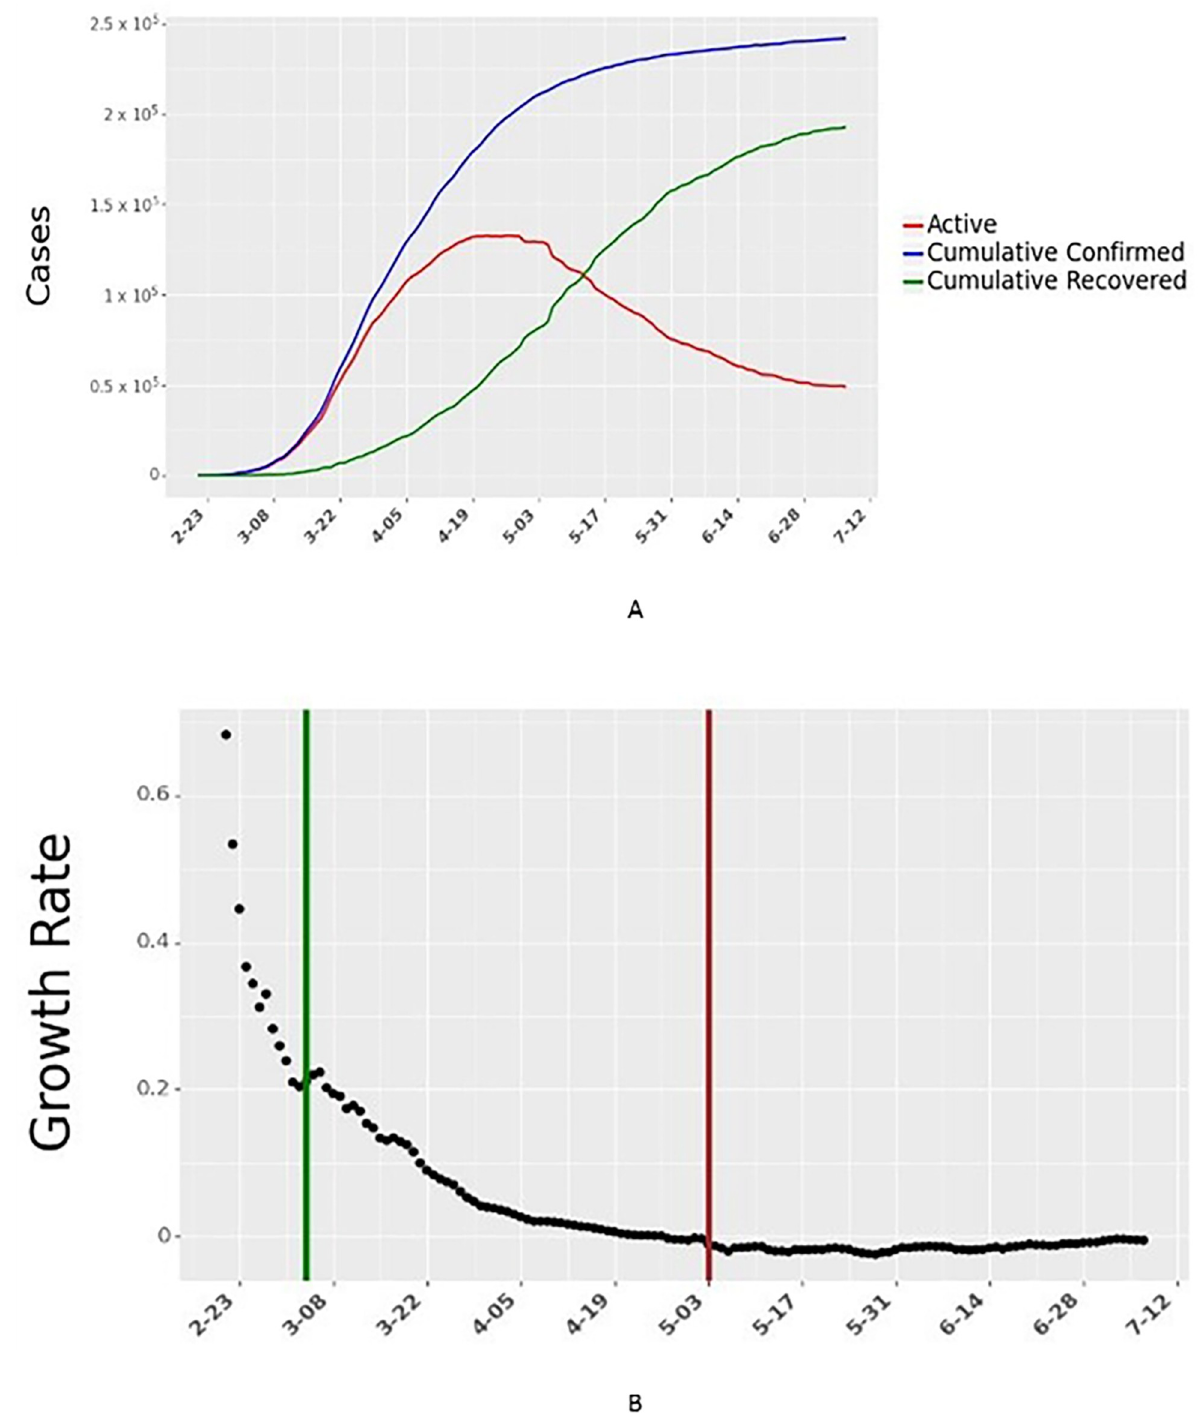
Fig 4. Daily active cases and growth rate of active cases for Italy. The vertical green line in Fig 4B shows the start of data collection for Italy. The vertical red line in Fig 4B shows the end of 60 days of data collection for Italy. Data for all 24 countries are shown in Figs F and G in S1 Text,